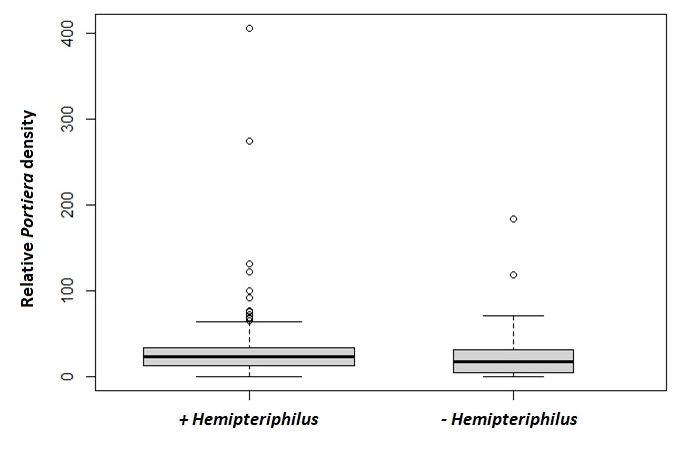
Figure 5. Ca. Portiera aleyrodidarum densities according to the presence of Ca. Hemipteriphilus asiaticus. Relative Ca. Portiera aleyrodidarum ( Portiera in the figure) densities (ratio of the number of copies of Ca. Portiera aleyrodidarum (16S rRNA) and host (actine) genes) in absence (- ; n=69) or presence (+ ; n=213) of Ca. Hemipteriphilus asiaticus ( Hemipteriphilus in the figure) within the same host individuals. The width of the box plots reflects the number of samples for each